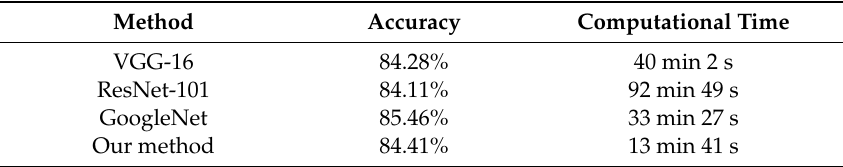
Table 10. Comparison results of advanced engineering